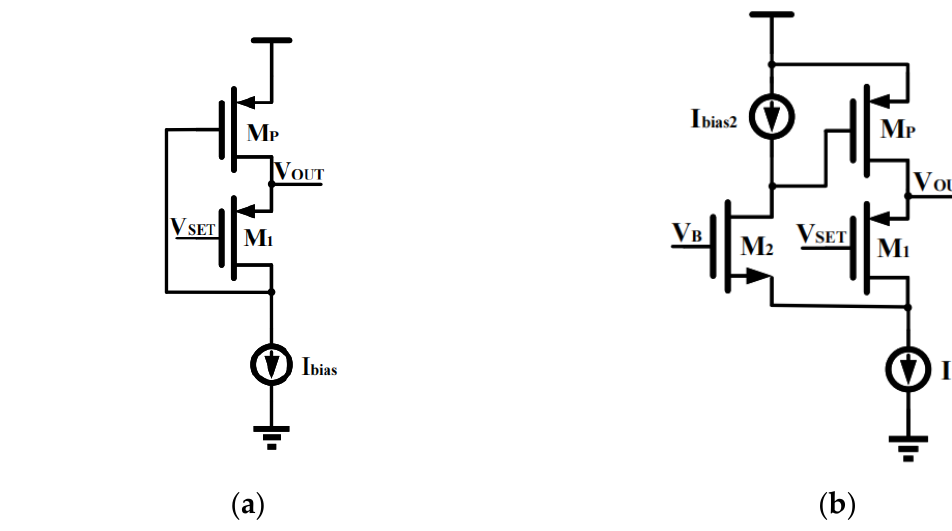
Figure 1. ( a ) Structure of an FVF; ( b ) Structure of a folded FVF.